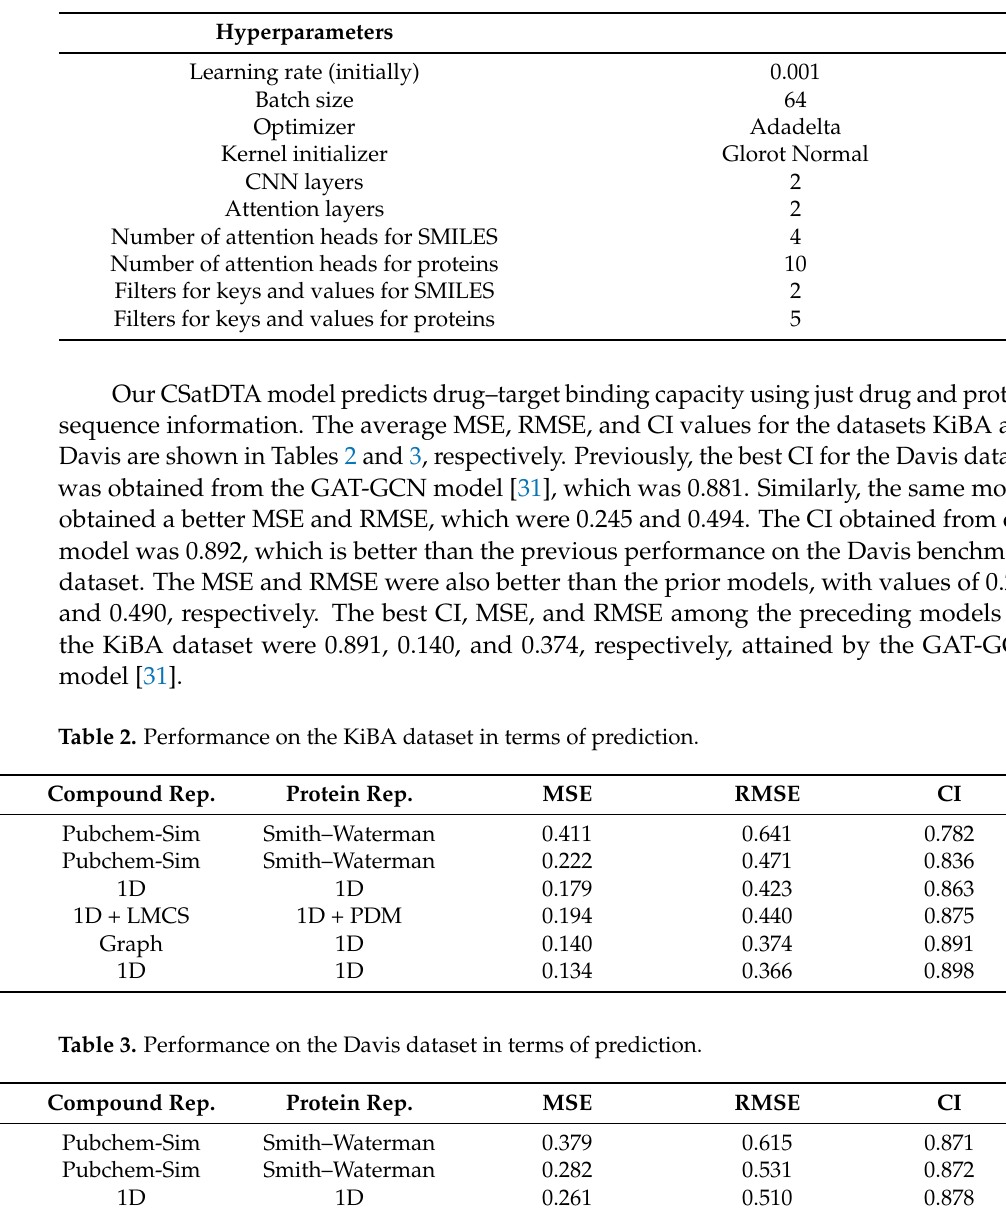
Table 1. Hyperparameters for CSatDTA.